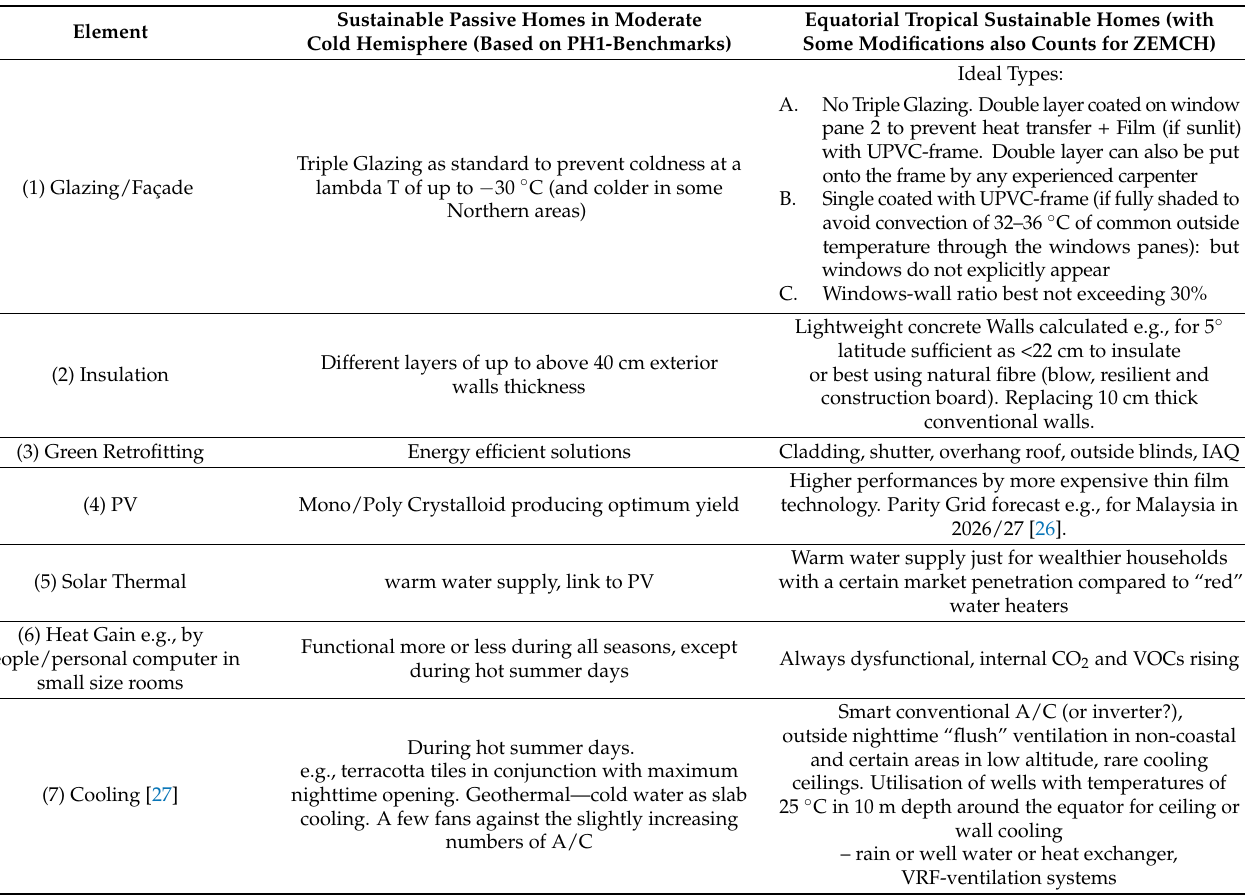
Table 2. Summary: 7 Differences of PH1 (any colder hemisphere) compared with Tropical Holistic Passive Technology